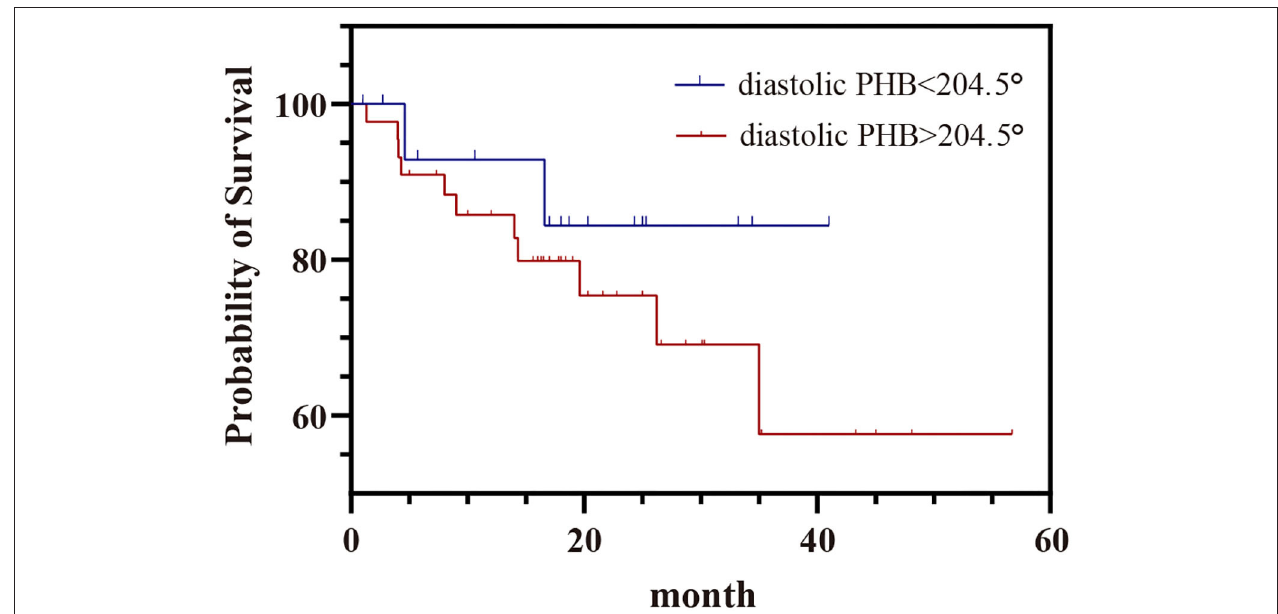
FIGURE 5 | Kaplan–Meier survival curve of MACE in patients with diastolic PHB < 204.5 ◦ and diastolic PHB > 204.5 ◦ . PHB, phase histogram